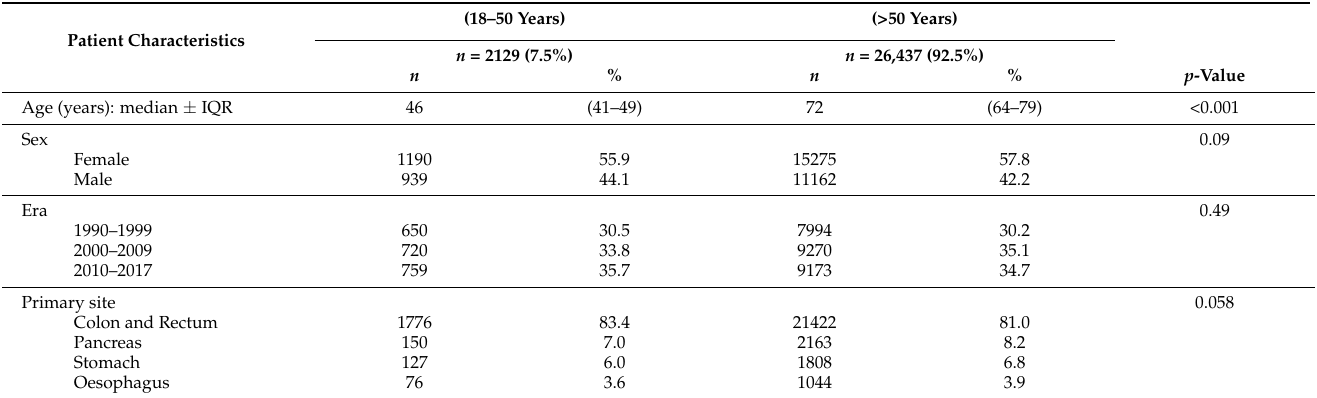
Table 1. Patient’s characteristics, era, and primary sites of cancer between two age groups (N = 28,566).